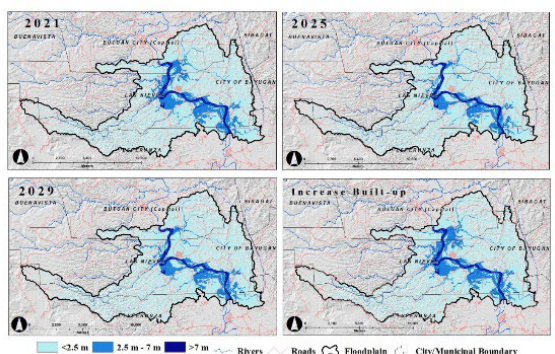
Figure 11 . Flood depth maps with a 50-year